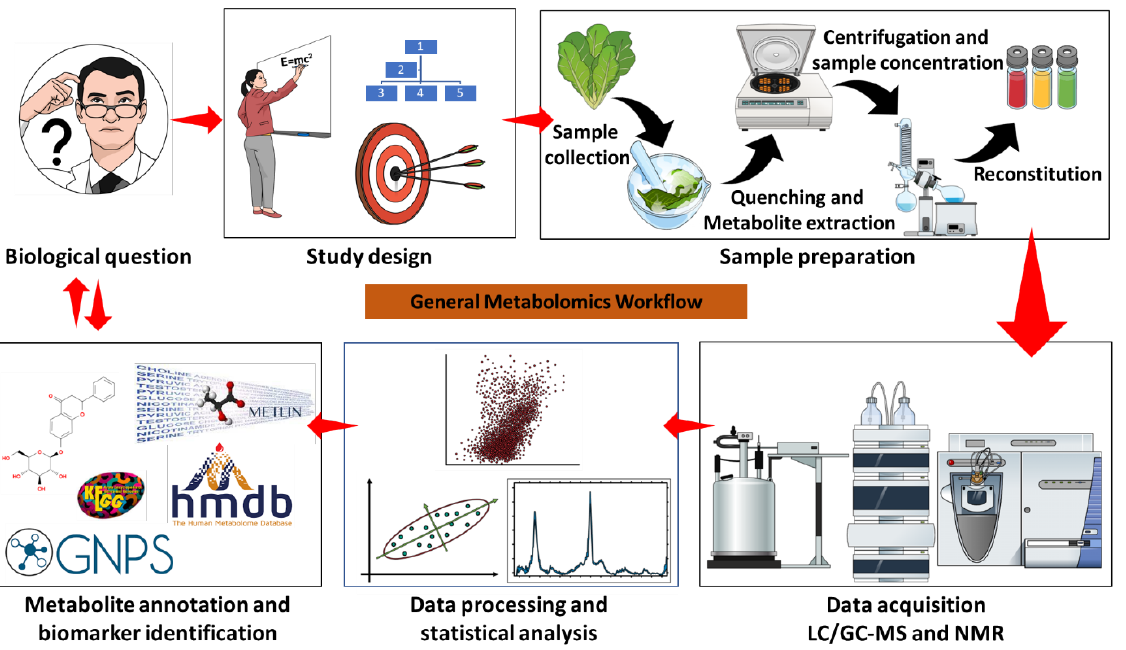
Figure 2. General metabolomics workflow. A typical metabolomics study is driven by a biological question, e.g., the elucidation of metabolic reprogramming in plants responding to abiotic stress. A study design determines the experimental parameters to source sample material, a suitable methodol- ogy for sample preparation, and the type of instrumentation to be used based on the research question and the aim of the study. Sample preparation can be different for NMR, LC-MS, and GC-MS, whereas data acquisition can be instrument-specific based on the experimental design and the objectives of the study, for instance, GC-MS is specific for the analysis of volatile compounds, and derivatization is required for non-volatiles. NMR is used for the elucidation of molecular and structural properties of compounds, while MS is used to determine the identities of unknown compounds using their molecular weight/formula to reveal structural and chemical properties. Specialised software (vendor- specific or free platforms) is used for data mining, processing, statistical analysis, and compound annotation and identification of